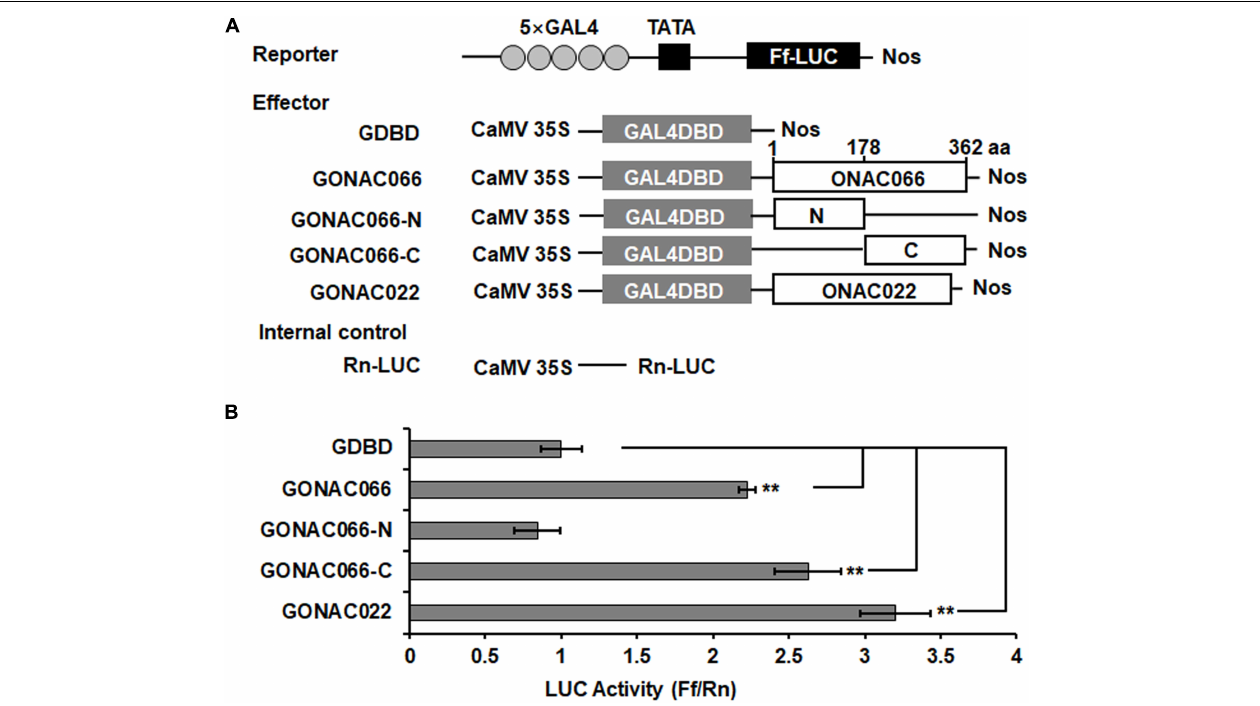
FIGURE 2 | Transactivation activity of ONAC066 in rice protoplasts. (A) Diagrams of the effector and reporter constructs used in panel (B) . Amino acid positions in ONAC066 are indicated above the GONAC066 construct. (B) Luciferase (LUC) activity assay of GAL4DBD and GAL4 element-mediated LUC activity by full length or truncated ONAC066 in rice protoplasts. Data represented in panel (B) are the means ± SD from three independent experiments and ** indicated significant difference at p < 0.01 by two-tailed unpaired Student’s t